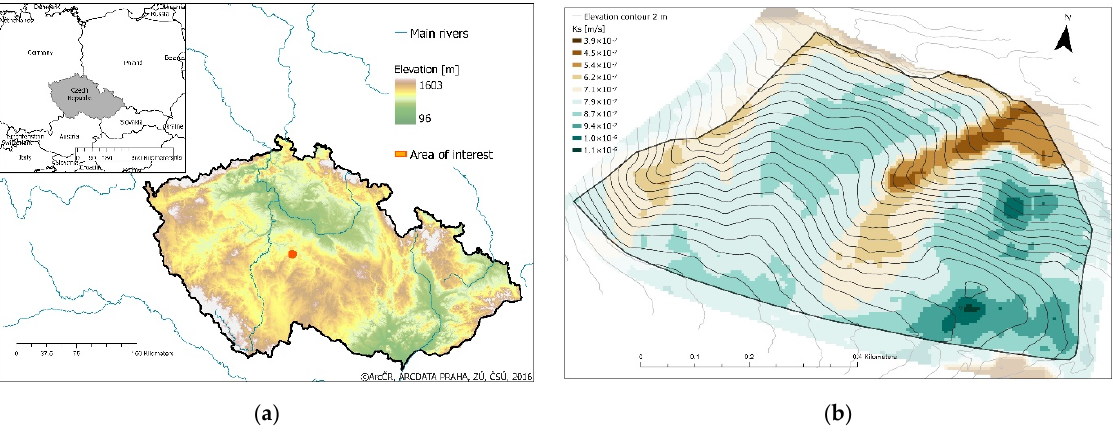
Figure 3. ( a ) Study area of the Czech Republic with Digital Terrain Model (©Arc Č R, ARCDATA PRAHA, ZÚ, Č SÚ, 2016 ® , http://www.arcdata.cz, accessed on 1 January 2022). ( b ) Spatial distribu- tion of Ks and elevation contours with 2 m intervals [48].